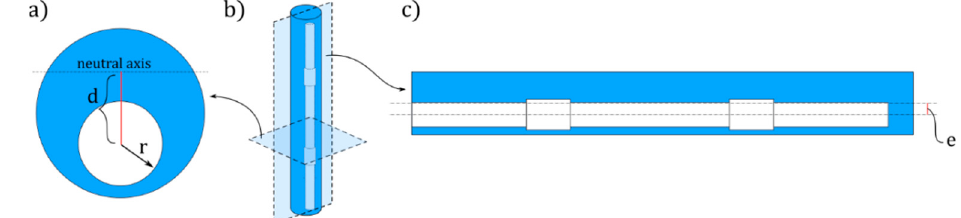
Figure 2. ( a ) Cross section of the microactuators. The distance between the neutral axis and the centre of the inflatable cavity (in white) is the moment arm d . ( b ) 3D representation of the microactuator with a Totem morphology of the inflatable chamber. Section planes are displayed. ( c ) Longitudinal section of the microactuator. The distance between the axis of the inflatable cavity and that of the rubber structure corresponds to the eccentricity, e .